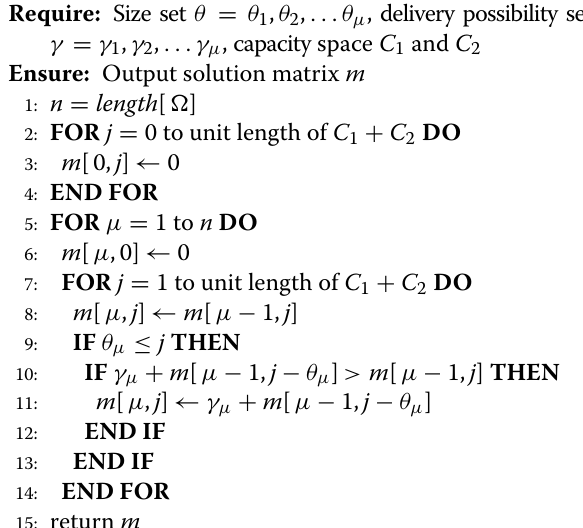
Algorithm 2 find solution matrix of Multiple